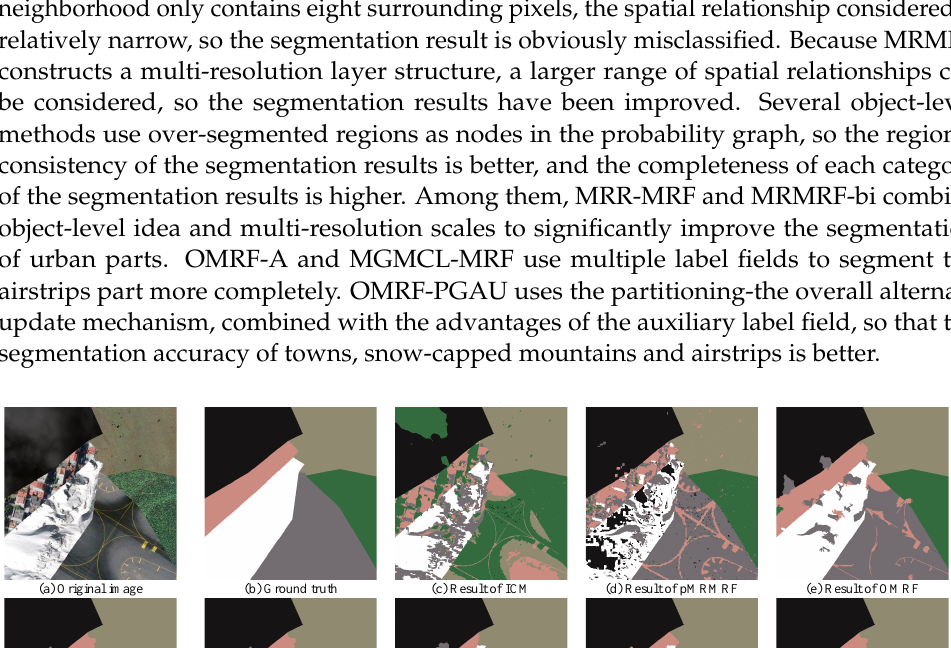
Figure 6. Semantic segmentation results for fiber cloth texture image.